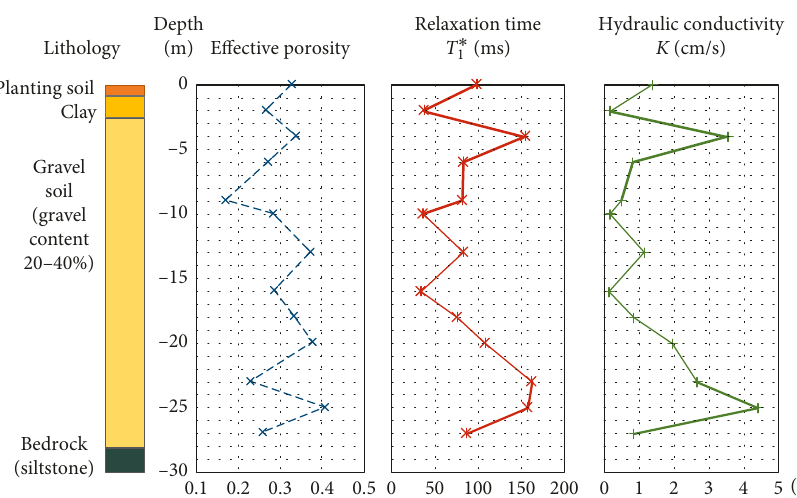
Figure 4: Comparison of drilled core lithology and the SNMR